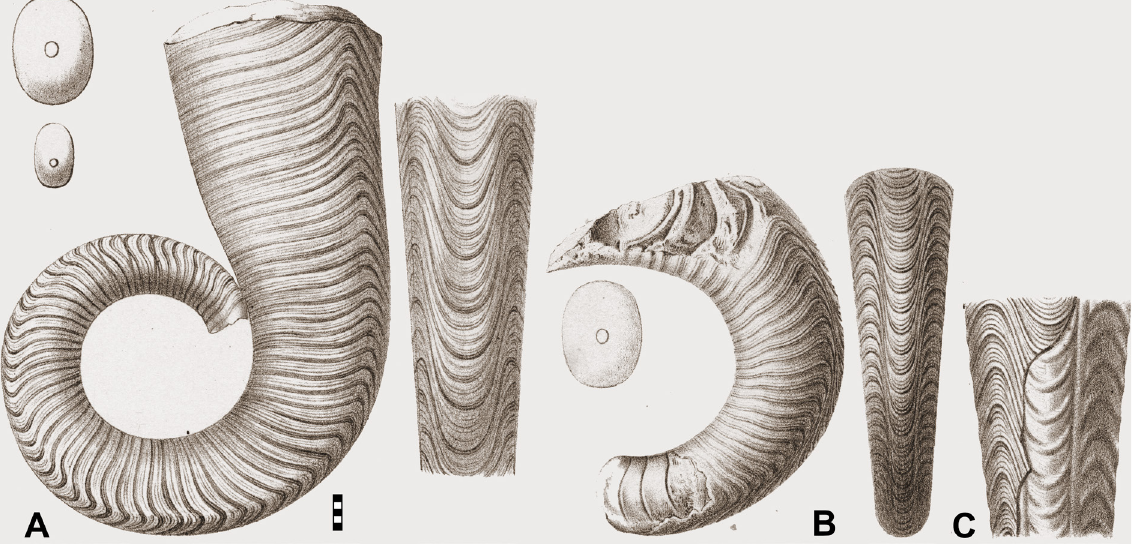
Fig. 27. Angelinoceras latum (Angelin, 1880); reproductions of illustrations of Remelé (1890). A . Specimen MB.C.11682 from Eberswalde (Brandenburg), illustrated by Remelé (1890: pl. 1 fig. 4). B . Specimen MB.C.11683 from Heegermühle (Brandenburg), illustrated by Remelé (1890: pl. 3 fig. 3). C . Specimen MB.C.11681 from Eberswalde (Brandenburg), illustrated by Remelé (1890: pl. 1 fig. 5). Scale bar units = 1